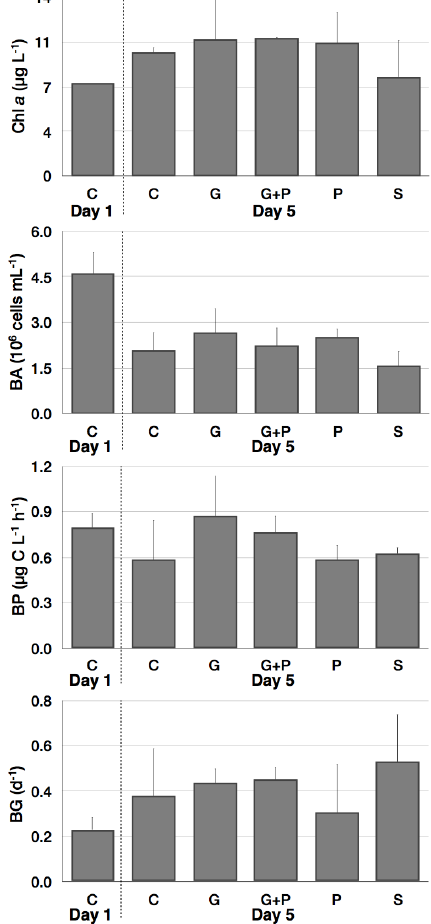
Figure 7. Planktonic variables in the 5-day experiment with amend- ments of glucose (G), glucose plus phosphorus (G + P), phospho- rus (P), and palsa soil (S) to SAS1B lake water. The control (C) is shown on both day 1 and day 5. Each value is the mean ± SD of triplicate